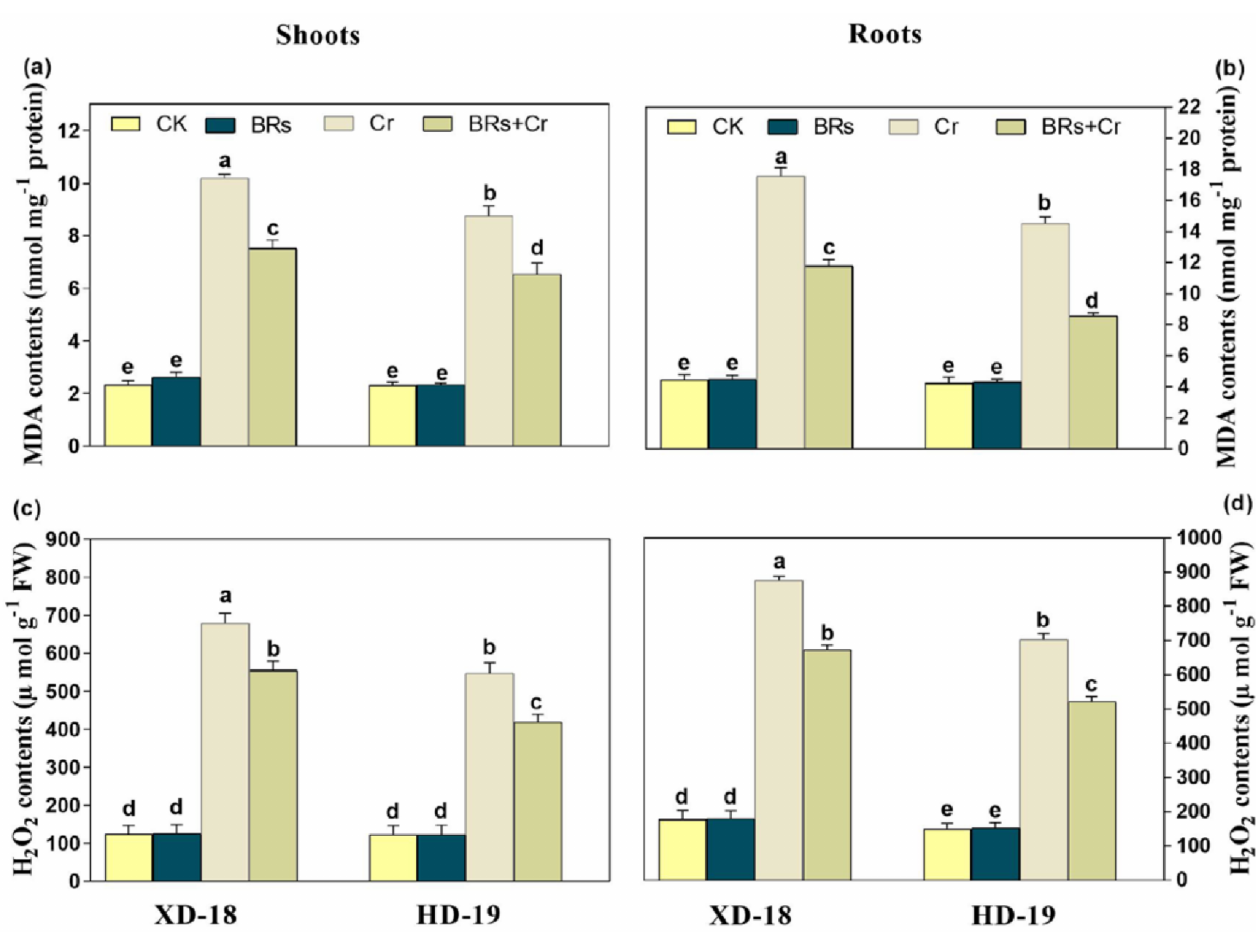
Figure 5. Effects of foliar-applied BRs on ( a ) MDA contents in shoots, ( b ) MDA contents in roots, ( c ) H 2 O 2, contents in shoots, and ( d ) H 2 O 2, contents in roots of two soybean genotypes (XD-18 and HD-19) under/without chromium (Cr) (0 and 100 µ M) stress. Values are the means ± SD of four independent replicates. Different alphabetical letters on bars indicate significant differences among the treatments ( p < 0.05) by the least significant difference